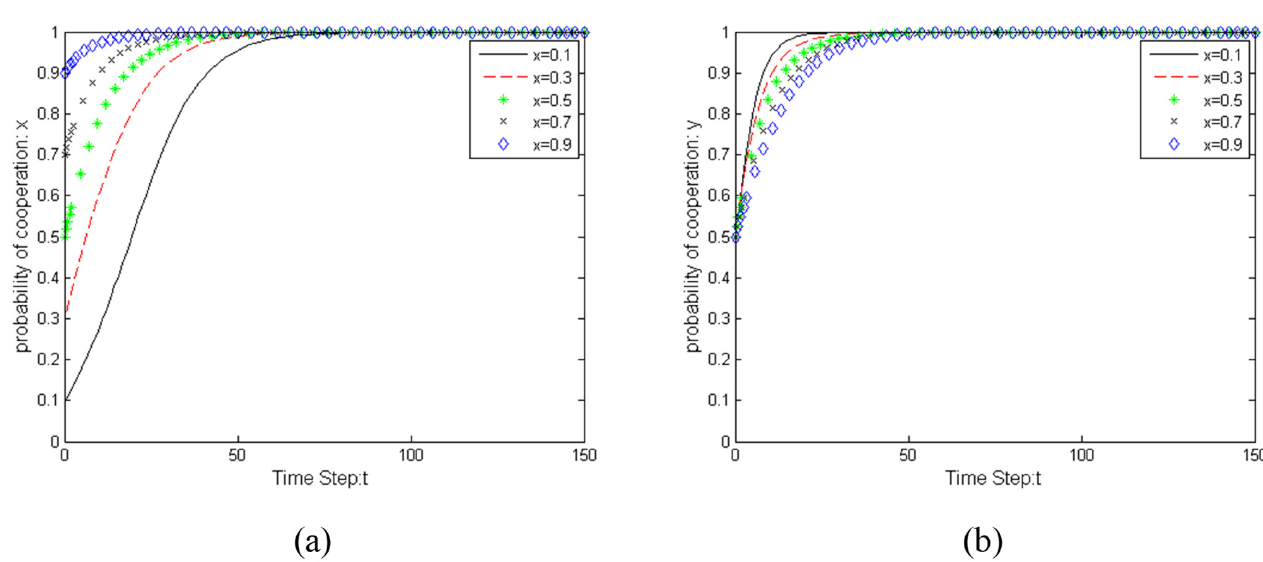
Figure 2. Evolution simulation, Scenario 2: ( a ) RDP; ( b ) hydropower developer. Water 2022 , 14 , x FOR PEER REVIEW